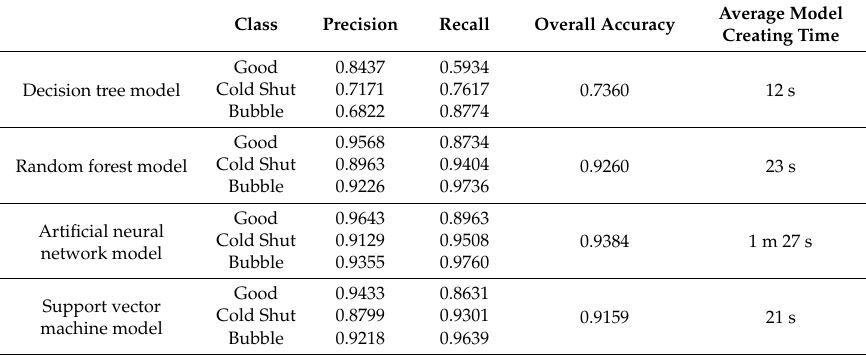
Table 7. Comparison of measurements between the quality-prediction